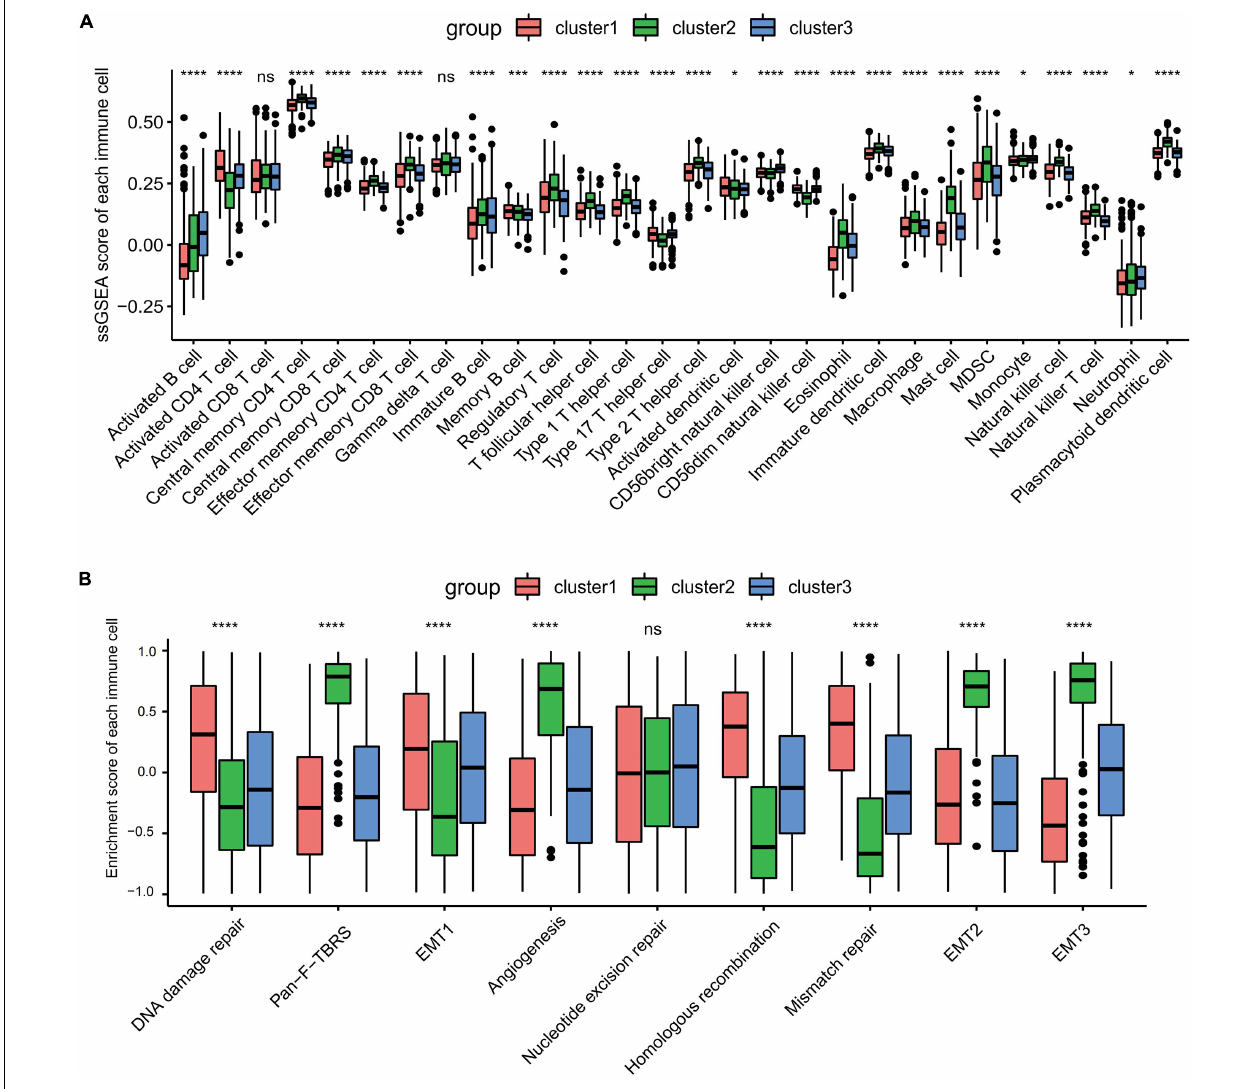
FIGURE 2 | Tumor microenvironment immune cell infiltration and transcriptome traits in distinct ferroptosis-related subtypes. (A) The abundance of each infiltrating immune cell in three distinct ferroptosis-related subtypes. ns , no significance. * p < 0.05; *** p < 0.001; **** p < 0.0001, as determined by the Kruskal–Wallis test. (B) Different activation status of the stromal activation pathways in three clusters, with asterisks representing the statistical p -values (**** p < 0.0001). ns , no